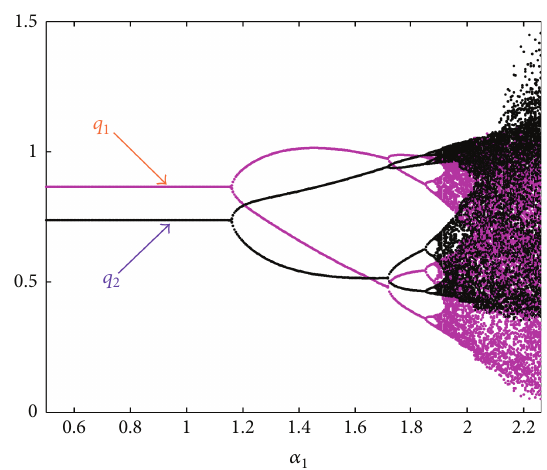
Figure 2: Bifurcation diagram of system (6) with 𝛼 1 ∈ (0.5, 2.2622] and 𝛼 2 = 1.46 .